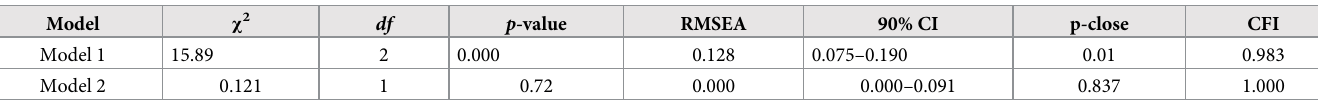
Table 1. Fit indices for the two unidimensional models of ERI affirmation.